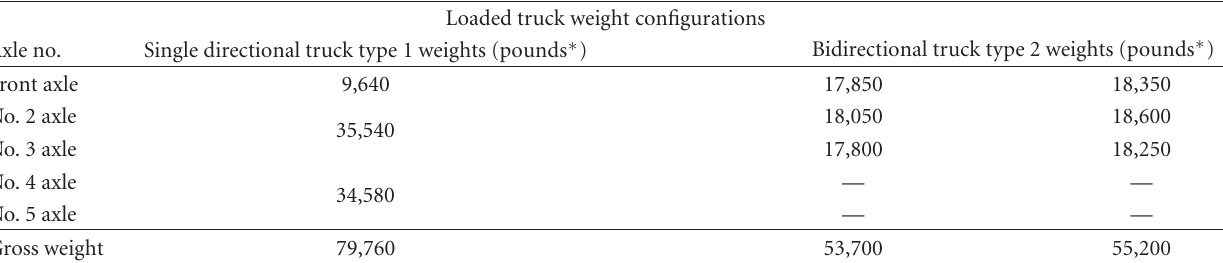
Figure 2: Gage layout and orientation for the Parkview Bridge. Table 2: Actual loaded truck